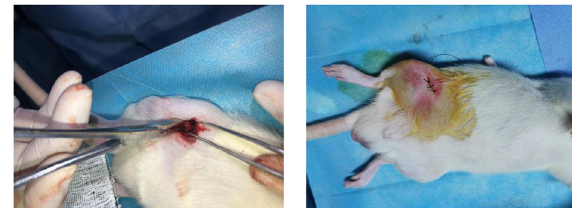
Fig. 1 Rats implantation